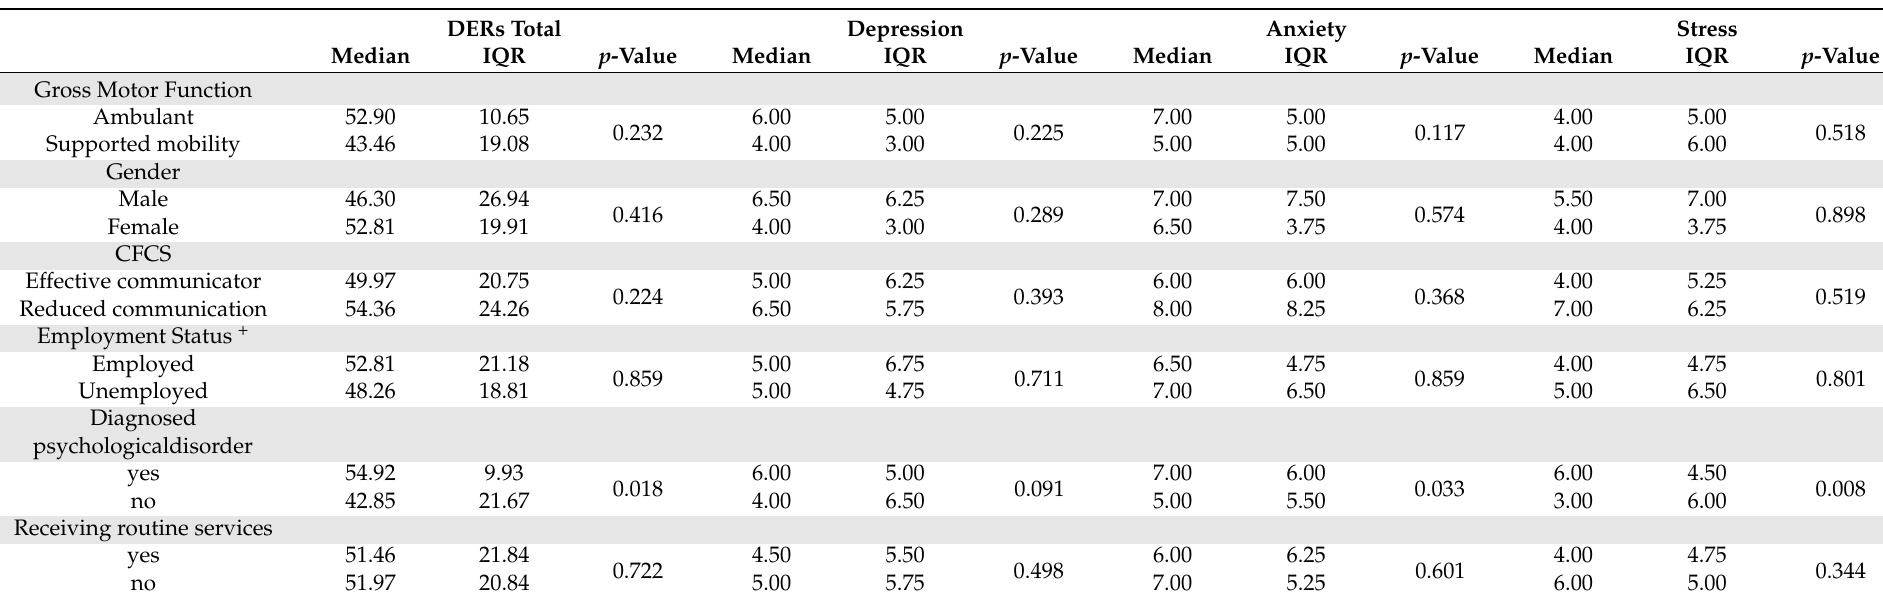
Table 4. Non-parametric examination of depression, anxiety, stress, and emotion regulation difficulties by socio-demographic factors. DERs Total Depression Anxiety Stress Median IQR p -Value Median IQR p -Value Median IQR p -Value Median IQR p